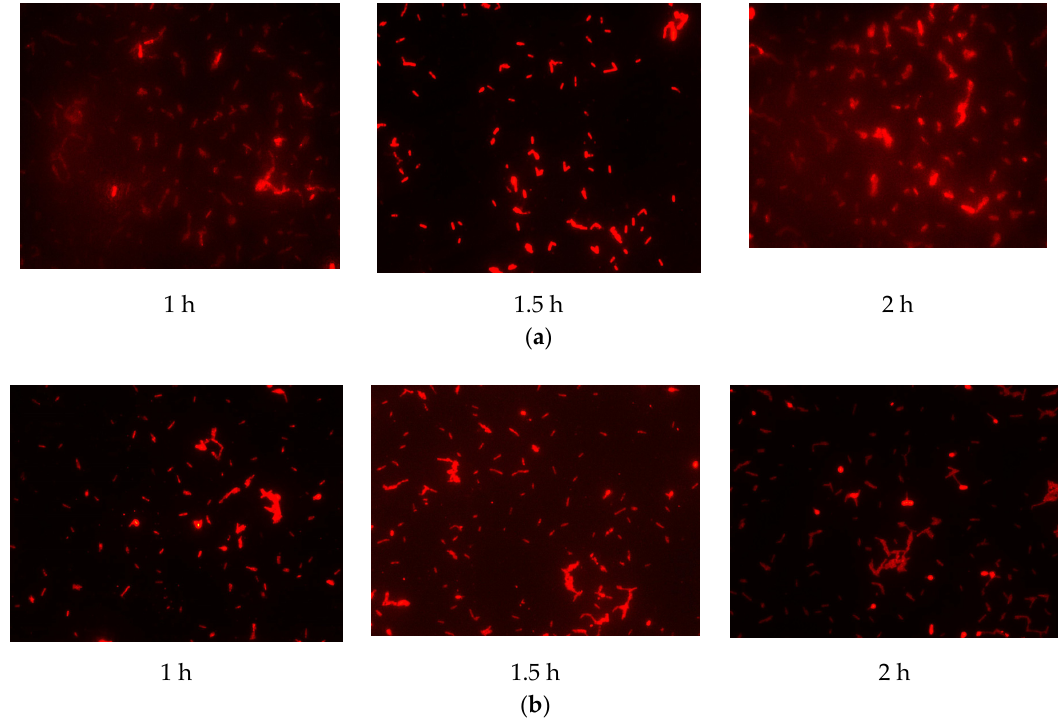
Figure 3. Identification of the optimal hybridization time for detecting coliform bacteria using FISH. E. coli ( a ) and E. aerogenes ( b ) cells were detected by FISH using specific probes for hybridization for different times at 50 °C.